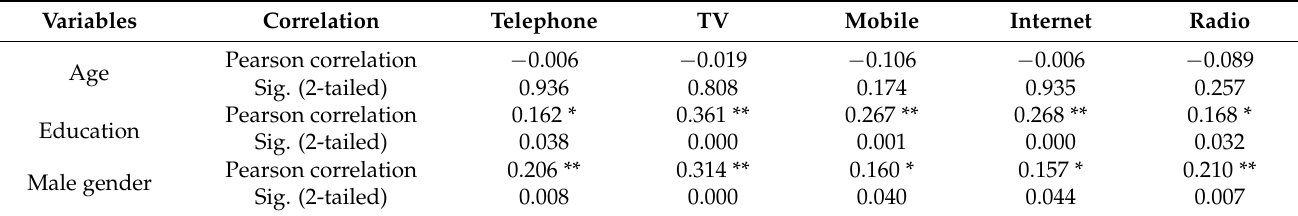
Table 3. Pearson correlation between socio-economic characteristics of the farmers and the utilization of EM.